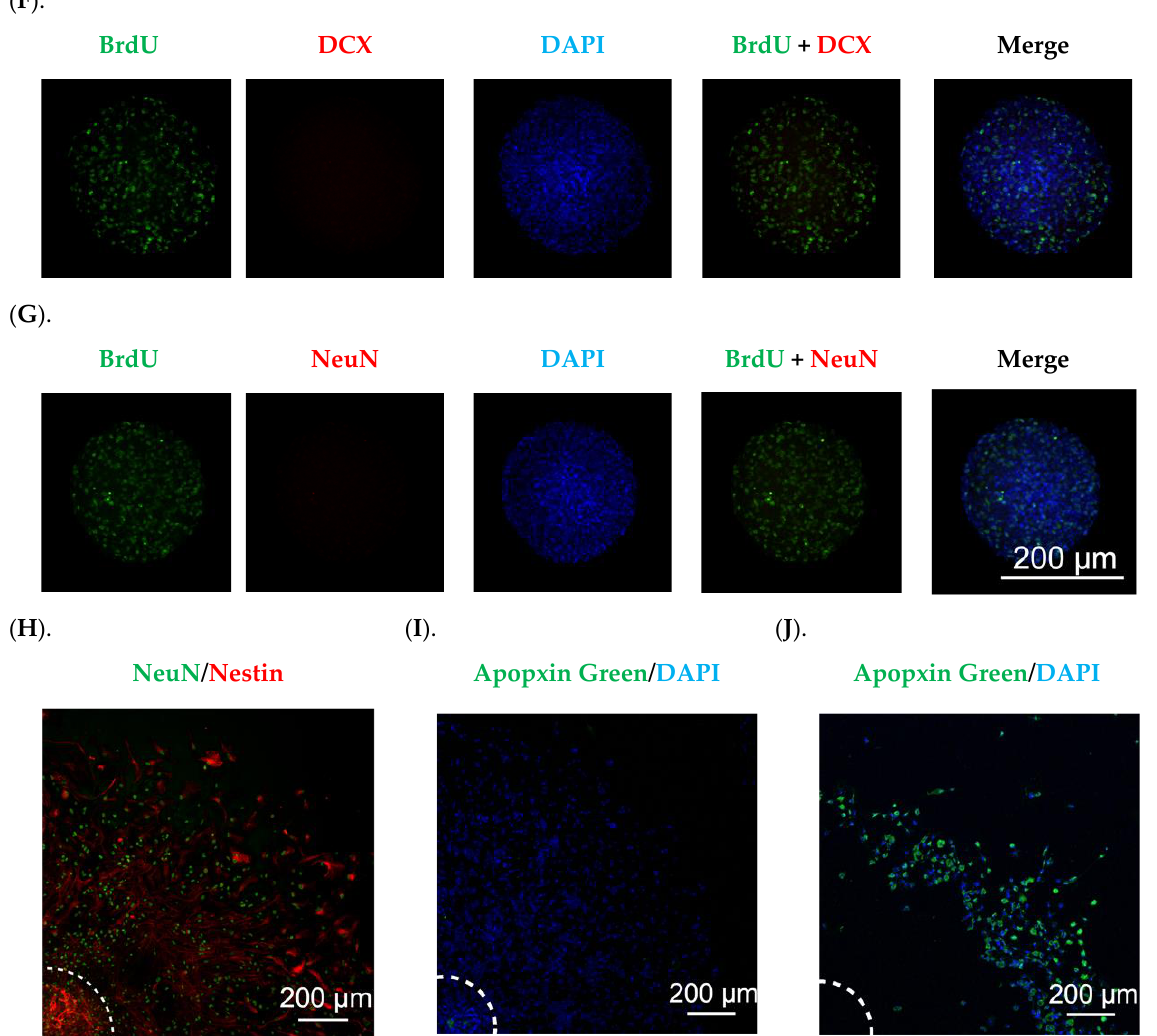
Figure 1. Establishment and characterization of in vitro neurospheres derived from adult SVZ. ( A ). An adult mouse brain was in a supine position; the dash line marks the optical chiasm where a coronal cut was made to expose the SVZ. ( B ). The SVZ tissues marked by the dash circle were isolated for disassociation. ( C ). The primary neurosphere formation was recorded for six days. Scale bar = 200 µ m. ( D ). A representative image of a secondary neurosphere. Scale bar = 100 µ m. ( E – G ). Characterization of secondary neurospheres by BrdU incorporation and staining with Nestin, DCX, and NeuN, respectively. Scale bar = 200 µ m. ( H ). Characterization of a differentiated neurosphere by Nestin and NeuN. Center of the neurosphere was marked by the dash lines. Scale bar = 200 µ m. ( I ). Neurospheres cultured in differentiation medium for 7 days showed negligible apoptotic signals, in contrast to neurospheres treated with 1.6 mM H 2 O 2 for 30 min showing robust apoptotic signals in ( J ). Centers of the neurospheres were marked by the dash lines. Scale bar = 200 μm.